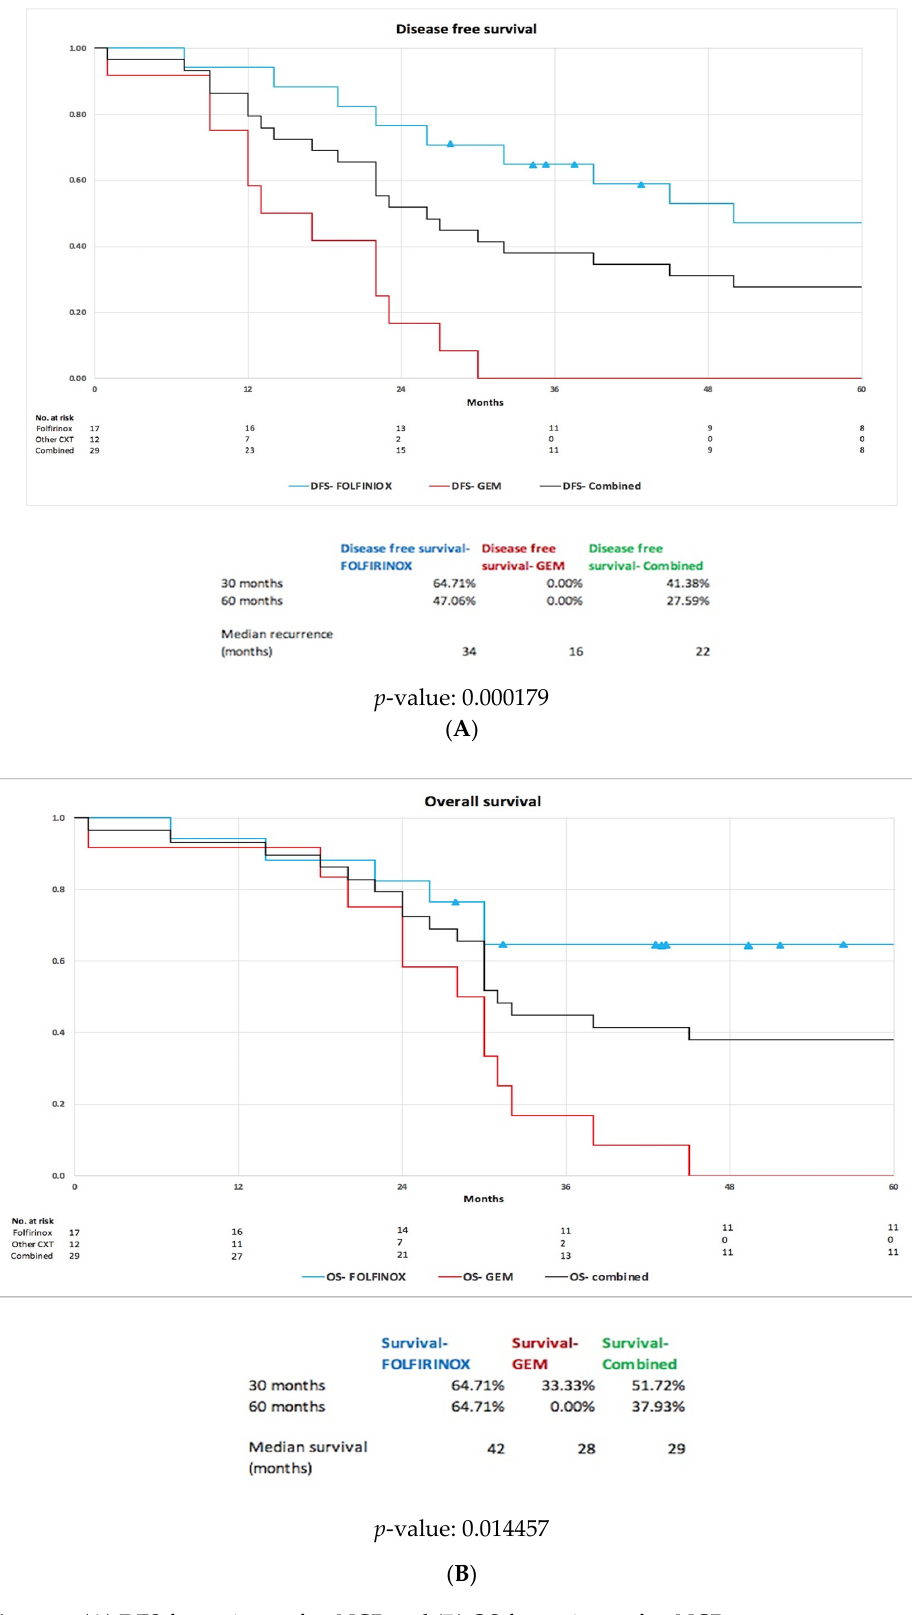
Figure 3. ( A ) DFS for patients after NCR and ( B ) OS for patients after